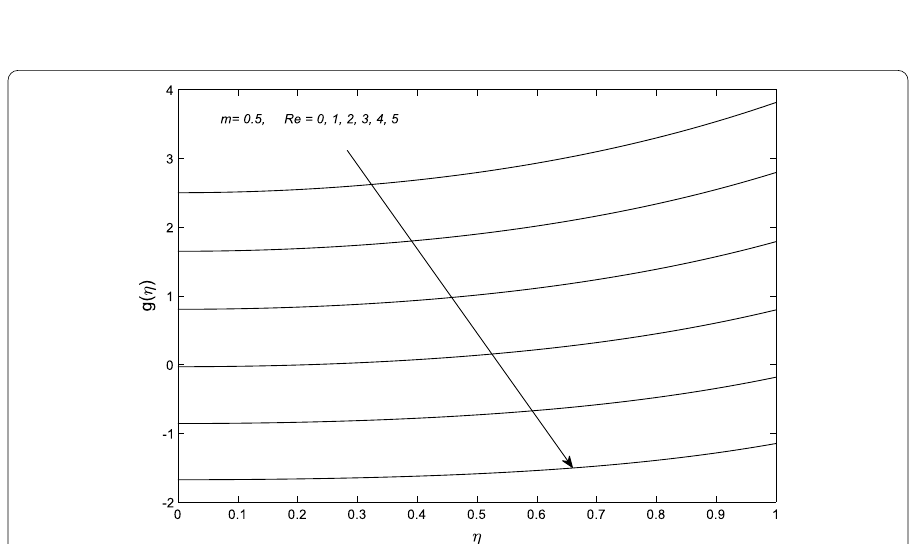
Fig. 4 g is graphed against η for different Re* where Re*